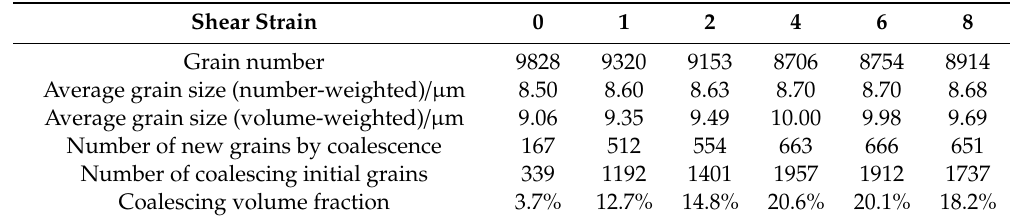
Table 2. Grain coalescence analysis results for the polycrystal with cube-type initial texture. Shear